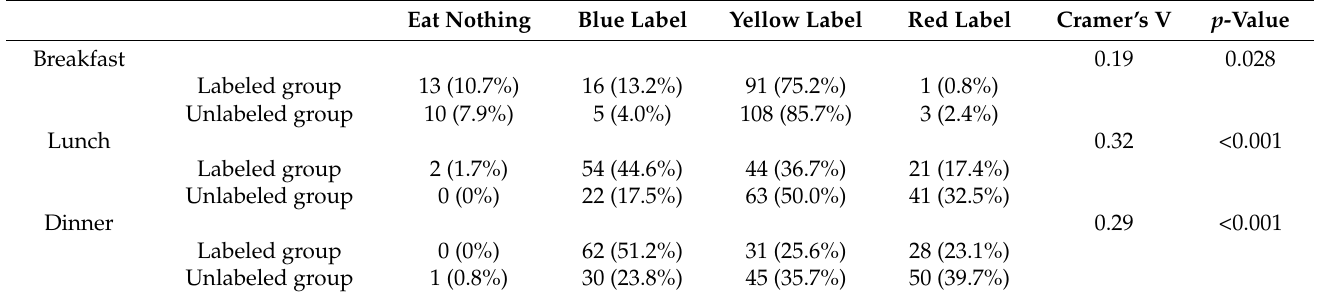
Table 2. Status of meal choices at breakfast, lunch, and dinner with and without TLF labels. Eat Nothing Blue Label Yellow Label Red Label